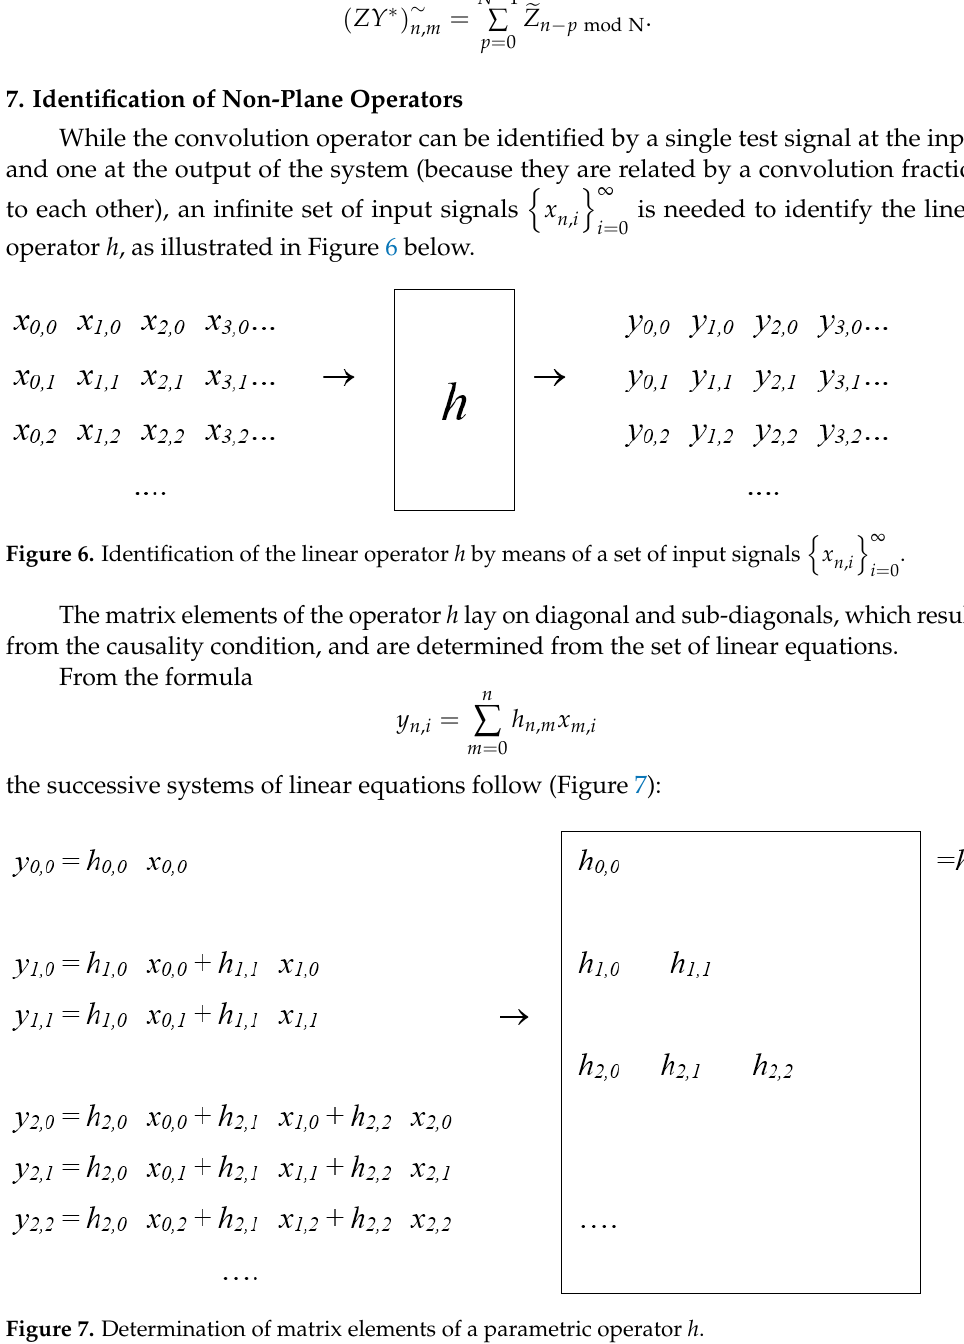
Figure 7. Determination of matrix elements of a parametric operator h . The sizes of the equation systems expand by 1 in each subsequent step. The set of input (cid:110) (cid:111) ∞ x signals must be independent, which takes place when the following determinants n , i i = 0 are non-zero (Scheme